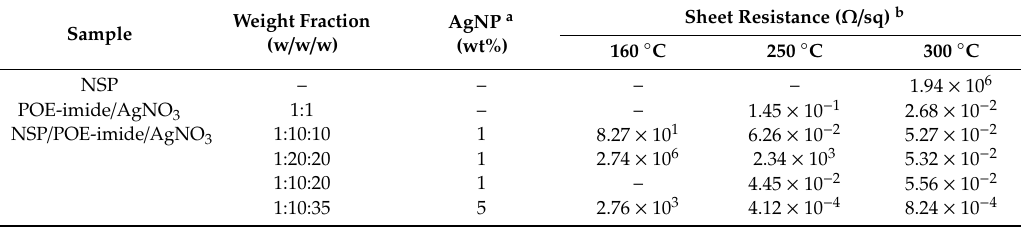
Table 1. Summary of sheet resistances of the NSP/POE-imide/AgNP nanohybrid films. Weight Fraction Sample